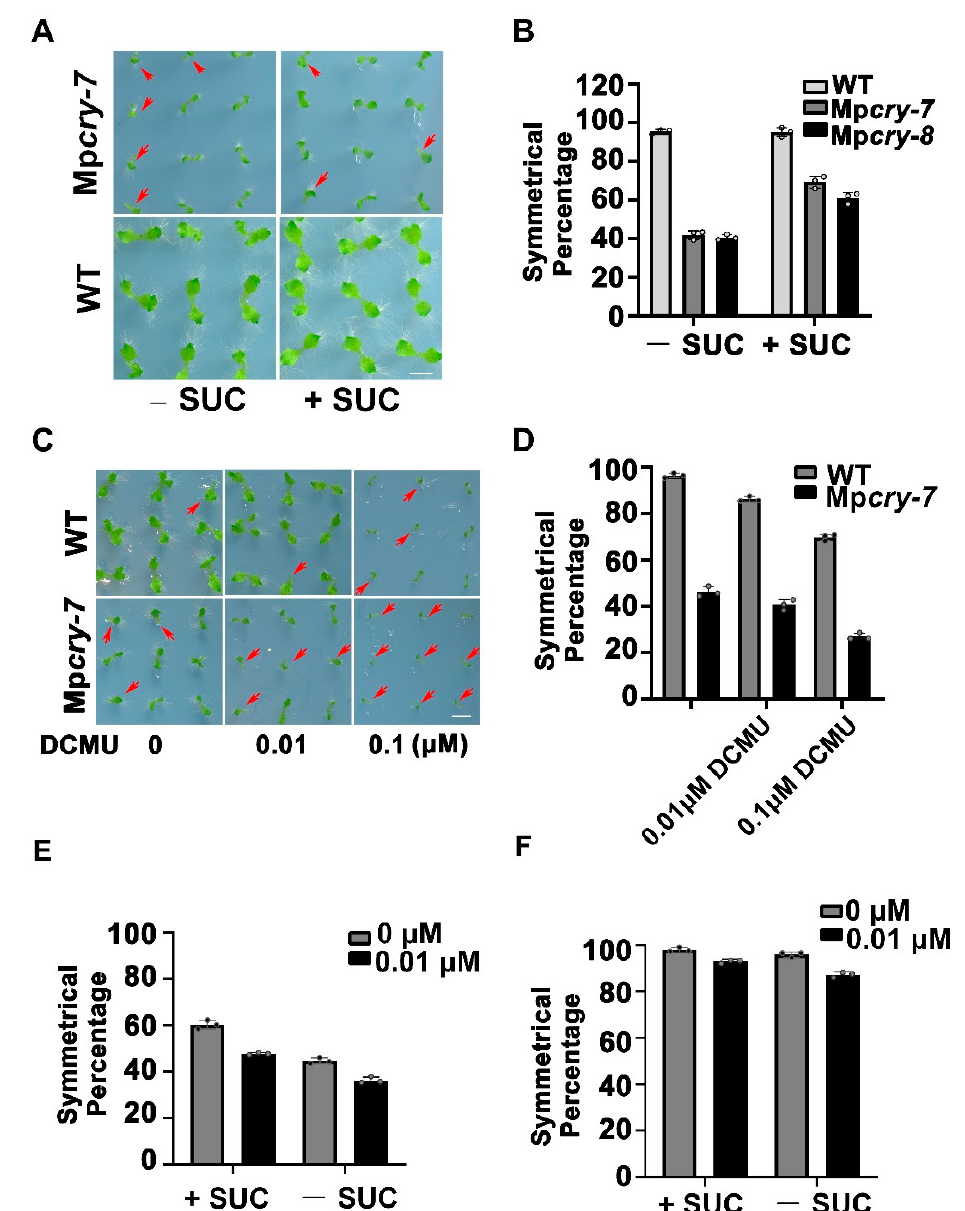
Figure 5. ( A ) Photographs of gemmalings treated without or with 1% sucrose in half-strength Gamborg’s B5 medium under BL (30 µ mol m − 2 s − 1 ) for 14 days. Bar = 5 mm. The red arrows represent individuals with asymmetric growth of thalli. ( B ) The symmetrical percentage in ( A ). Data are presented as mean ± SD ( n = 3 biological statistics, small black circles). More than 100 gemmalings were used for one count. ( C ) Photographs of gemmalings treated with different concentrations of DCMU in half-strength Gamborg’s B5 medium under BL (30 µ mol m − 2 s − 1 ) for 14 days. Bar = 5 mm. The red arrows represent individuals with asymmetric growth of thalli. ( D ) The symmetrical percentage in ( C ). Data are presented as mean ± SD ( n = 3 biological statistics, small black circles). More than 100 gemmalings were used for one count. ( E , F ) The symmetrical percentage of symmetrically grown gemmalings in Mp cry ( E ) and in WT ( F ). Gemmae were planted on the indicate culture medium under BL (30 µ mol m − 2 s − 1 ) for 5 days. +SUC and − SUC represent the culture medium with or without 1% sucrose. Black and Grey column represent the culture medium with and without 0.01 µ M DCMU respectively. Data are presented as mean ± SD ( n = 3 biological statistics, small black circles). More than 100 gemmalings were used for one